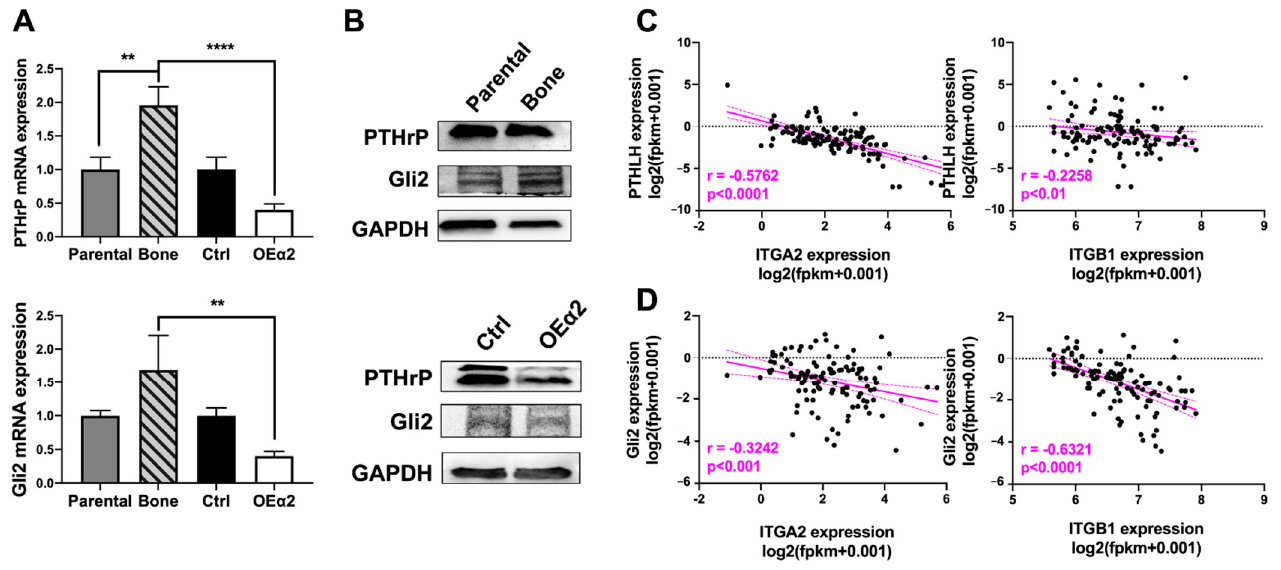
Figure 5. MDA-Parental, MDA-Bone, MDA-Ctrl, and MDA-OE α 2 cells were analyzed for osteolytic gene expression by ( A ) qPCR and ( B ) western blot analysis. Tumor cells overexpressing the α 2 integrin subunit had decreased PTHrP and Gli2 expression compared to bone and control cells (each set at 1). N = 3 biological replicates. Student’s t -test. ** p < 0.01, **** p < 0.0001. ( C , D ) RNA sequencing analysis from metastatic breast cancer biopsies from the MET500 cohort was analyzed for correlation between ( C ) PTHLH, ITGA1, and ITGB1, and ( D ) Gli2, ITGA2, and ITGB1 gene signatures. Spearman correlation analysis reveal a significant negative correlation between integrin α 2 β 1 and osteolytic genes. N = 120 tumor